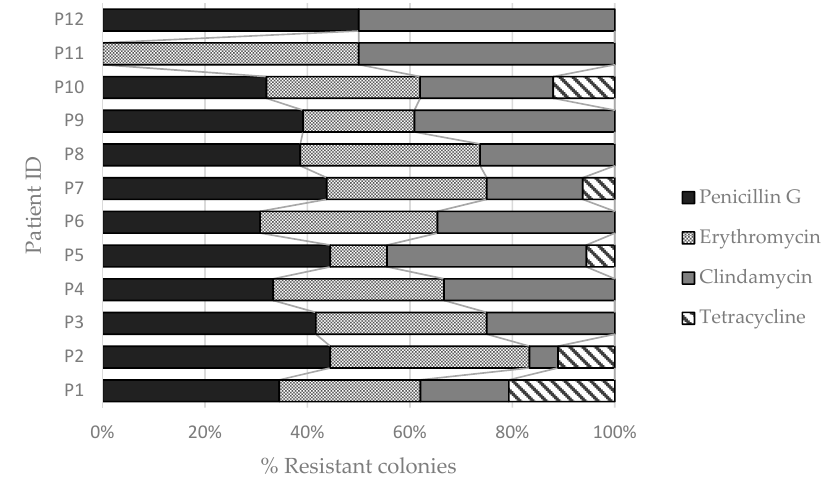
Figure 2. Percentage of environmental bacteria resistant to penicillin G, erythromycin, clindamycin, and tetracycline, found in the surroundings of each patient.